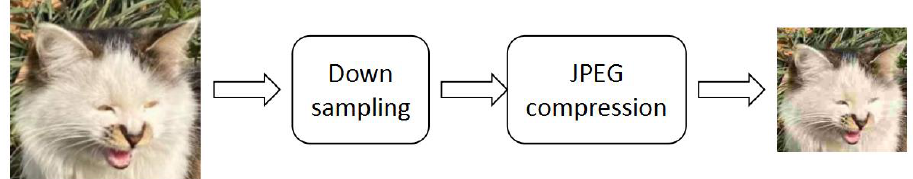
Figure 1. Degradation process for compressed LR images.